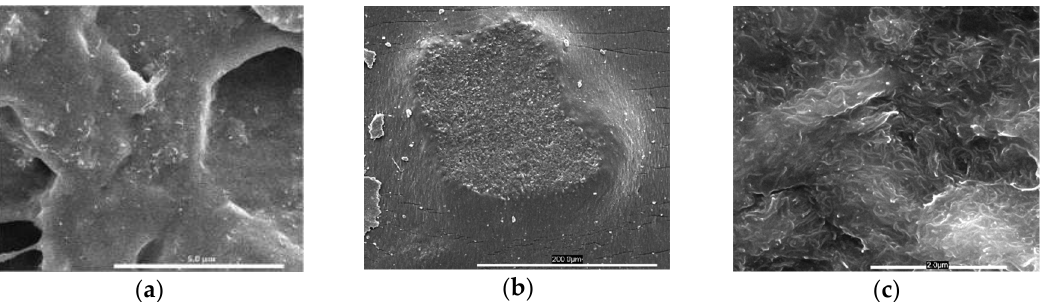
Figure 2. Representing SEM images of CNT/VMQ composites. ( a ) good CNT dispersion inside a CNT/VMQ composite specimen. ( b ) CNT agglomerate inside the composite. Note the matrix presence inside the agglomerate, and the ripples around it. ( c ) zoom-in into the agglomerate in figure b. Note that despite the high CNT concentration, all of them are encapsulated within a matrix.